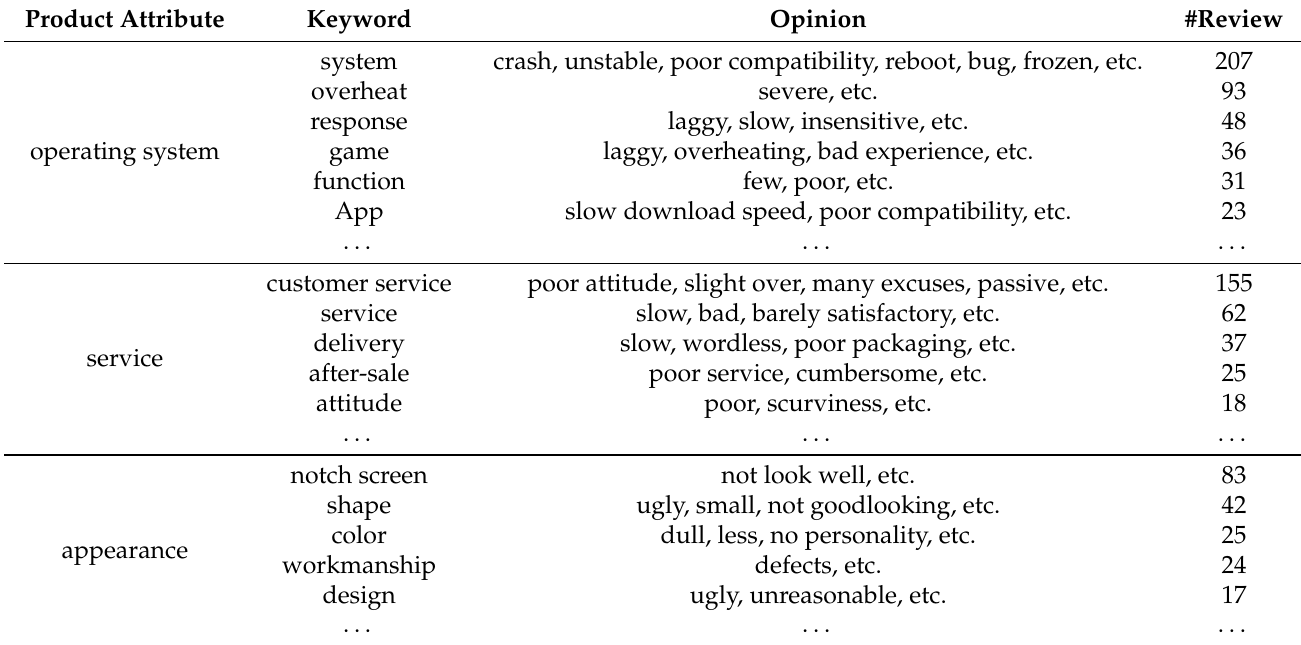
Table 9. Opinion mining in negative reviews for iPhone